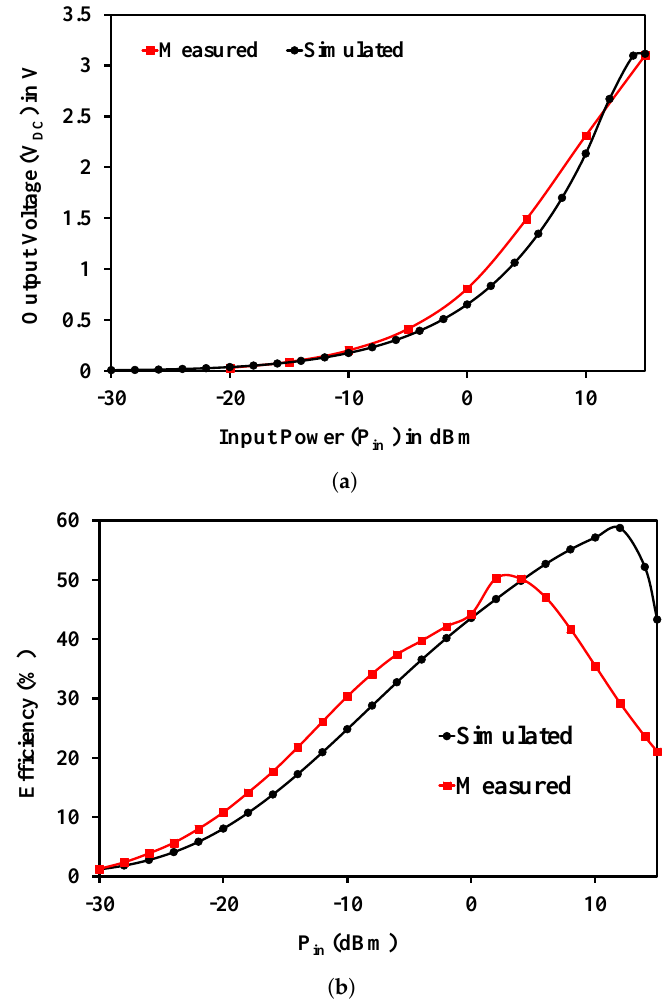
Figure 6. Simulated and measured: ( a ) Output DC voltage sweep against the input power ( b ) PCE sweep over an input power P in at 900 MHz. Table 1. Comparison of the proposed rectifier and